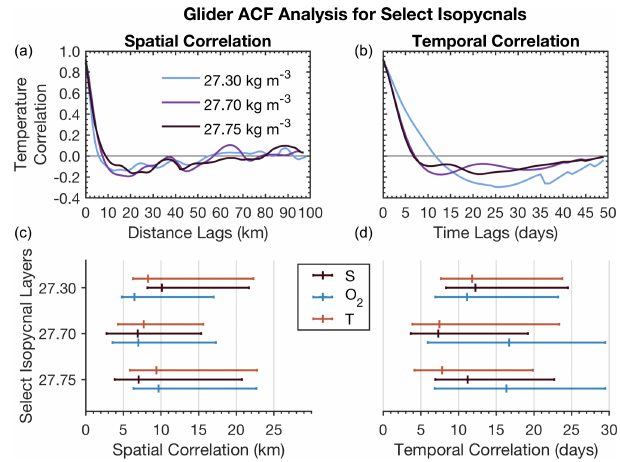
Figure 9. Upper panels show example autocorrelation functions for T as a function of distance and time lags. Lower panels summarize zero crossings for T , S , and O 2 in space and time lags for shown isopycnals together with 95% CI